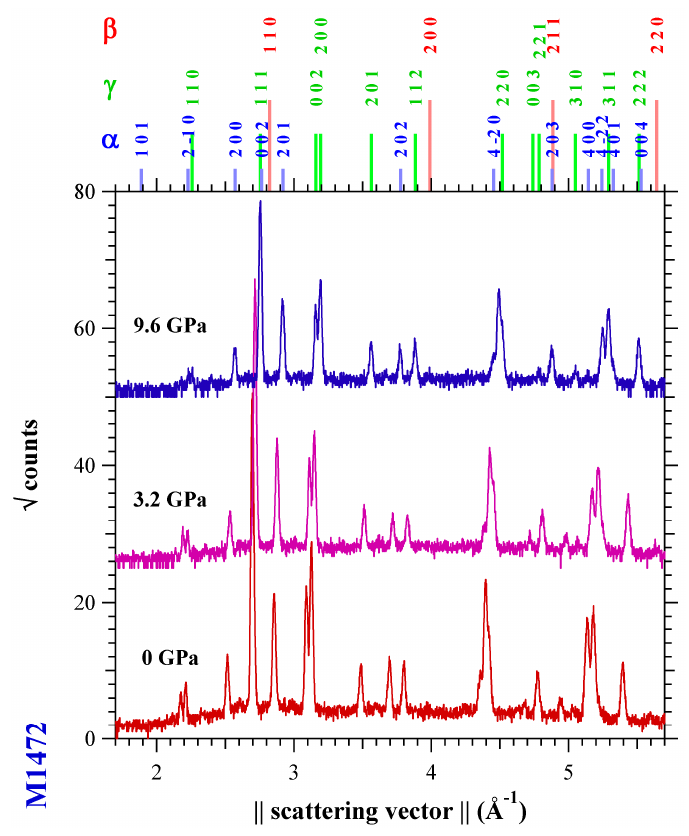
Figure 6. Diffraction patterns upon pressurizing. Line shifts to larger scattering vectors can be seen as the unit cell shrinks, accompanied by changes of peak intensity due to phase